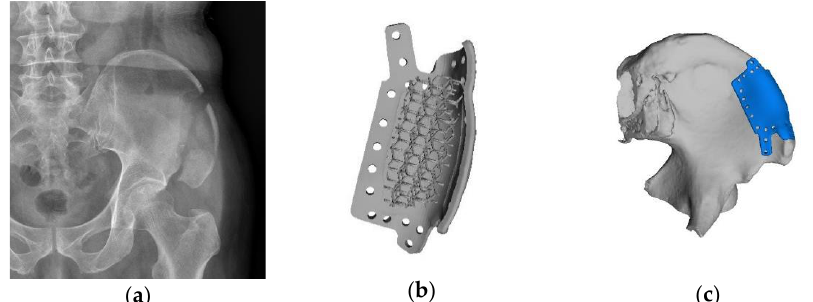
Figure 2. ( a ) Fractured iliac bone; ( b , c ) computer-based planning and designed titanium implant.